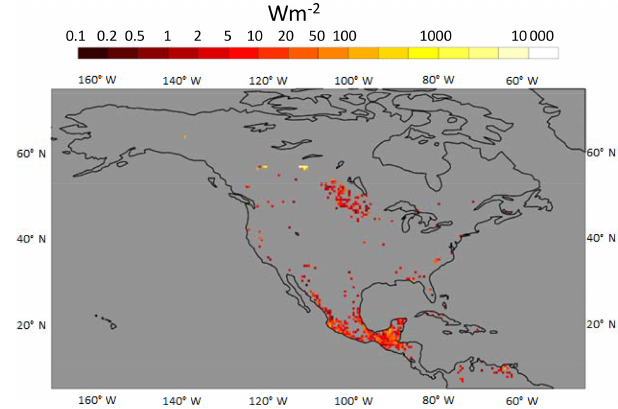
Figure 10. CAMS daily fire product for 17 May 2016. Colours show the average of the observed fire radiative power areal density in Wm − 2